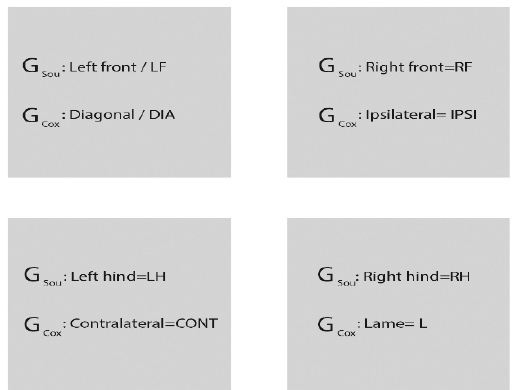
Figure 1. The G Sou and G Cox dog limbs nomenclature scheme. G Sou (group sound); G Cox (group coxarthrosis); LF (left front limb); RF (right front limb); LH (left hind limb); RH (right hind limb); DIA (diagonal limb); IPSI (ipsilateral limb); CONT (contralateral limb); L (lame limb).